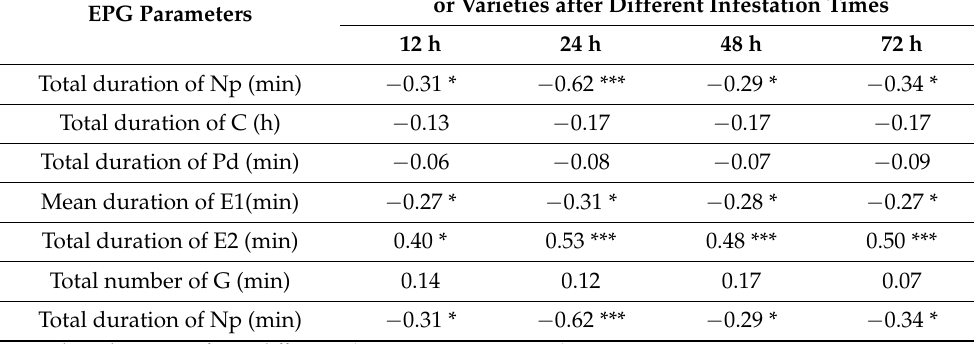
Table 4. Linear correlations between EPG parameters and winged S. miscanthi settled on wheat accessions and varieties 12, 24, 48, and 72 h after being released. Percentage of Winged Aphids Settled on Wheat Accessions or Varieties after Different Infestation Times EPG Parameters 12 h 24 h 48 h 72 h Total duration of Np (min) − 0.31 * − 0.62 *** − 0.29 * − 0.34 * Total duration of C (h) − 0.13 − 0.17 − 0.17 − 0.17 Total duration of Pd (min) − 0.06 Mean duration of